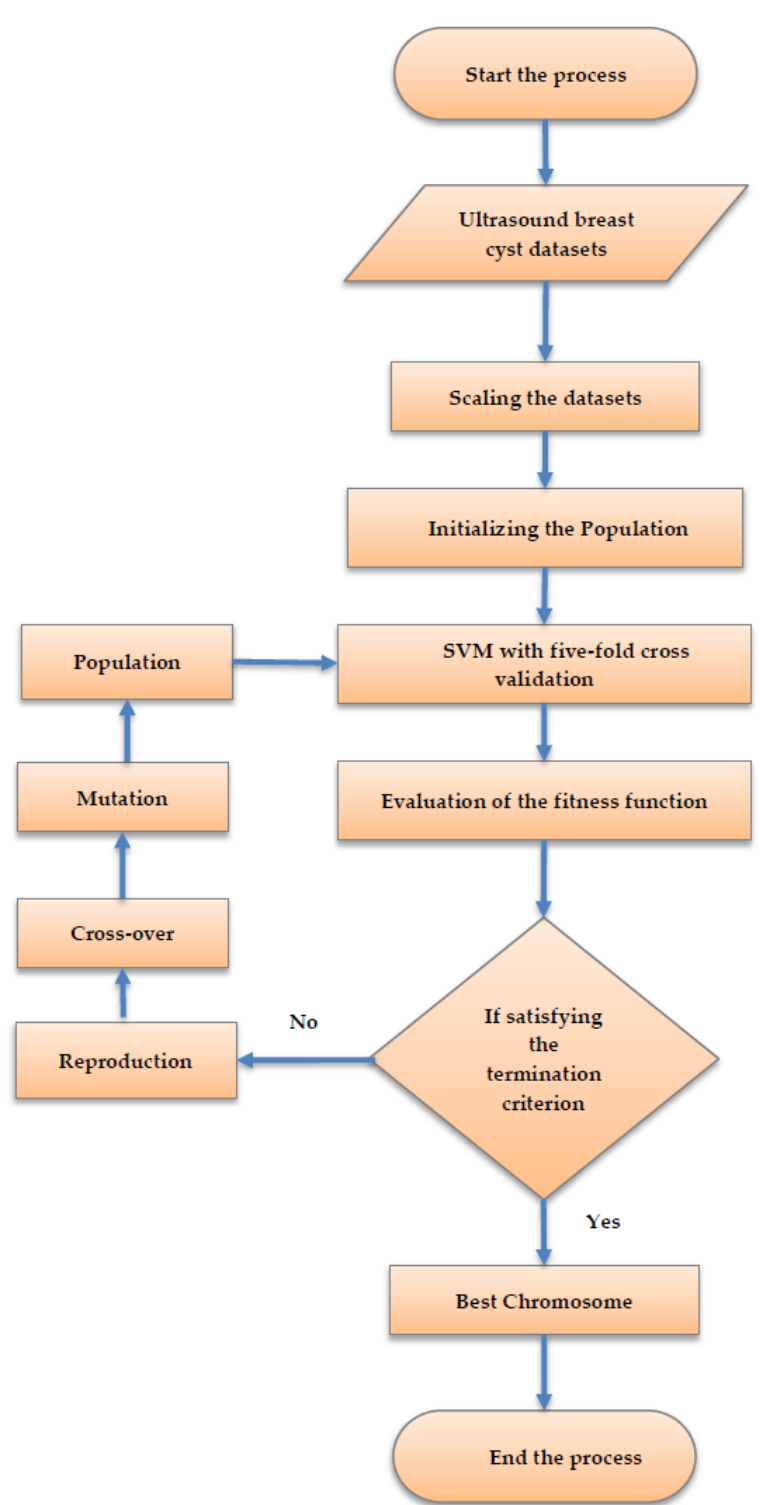
Figure 4. The schematic flow diagram for selecting the set of features utilizing the intelligent genetic algorithmic approach.